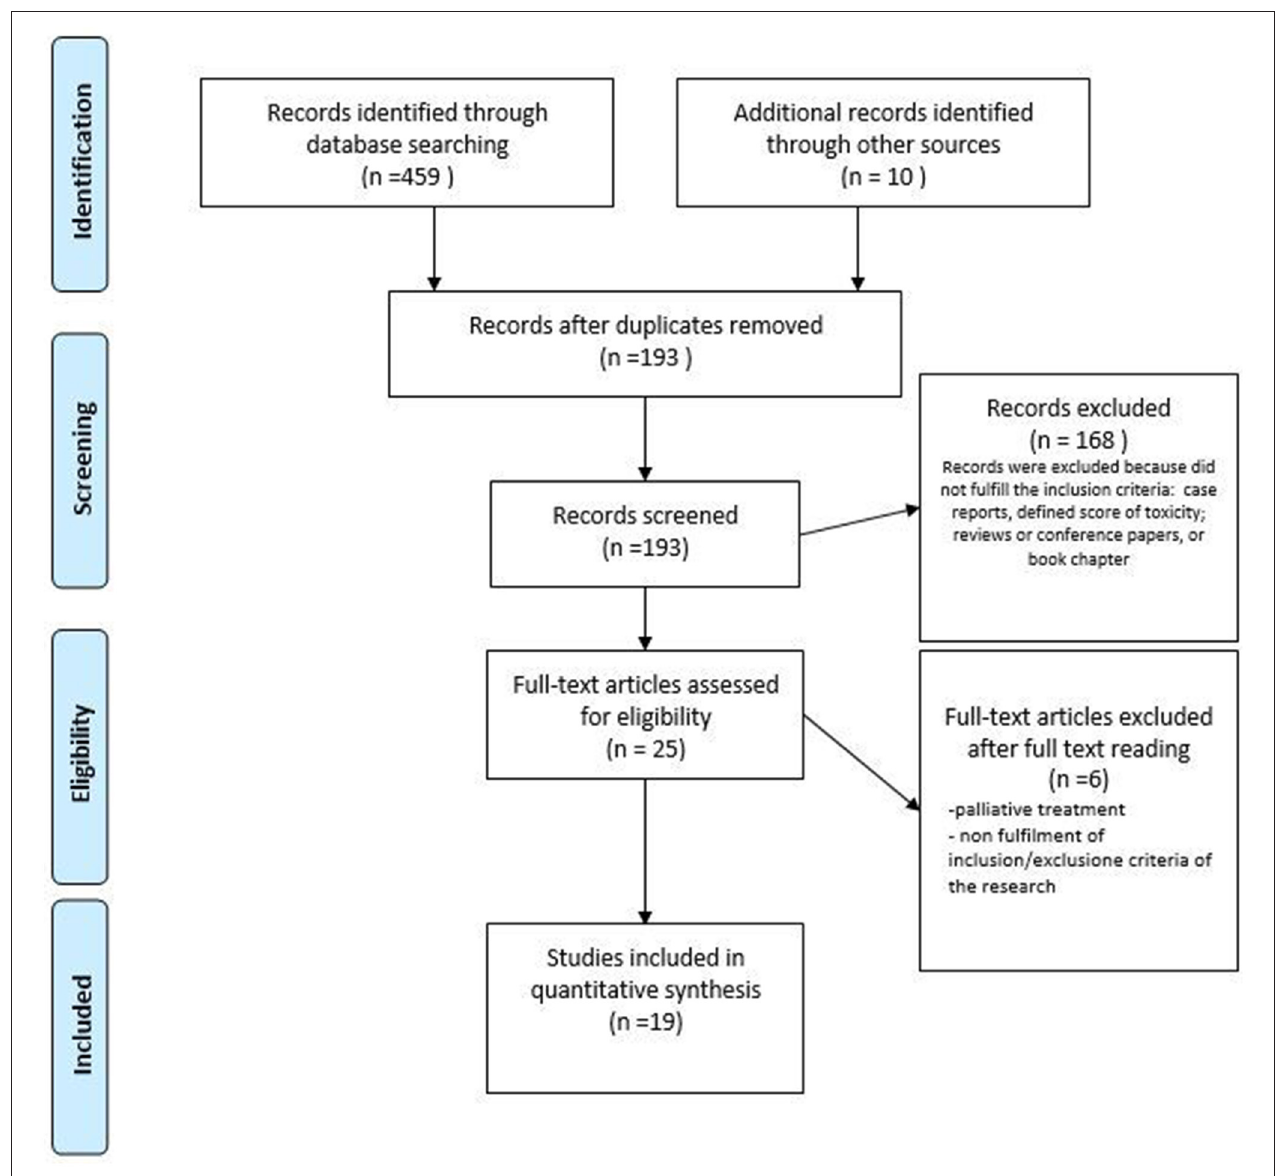
FIGURE 1 | PRISMA flow diagram of the study selection process for vulvar and vaginal radiotherapy toxicity. Adapted from